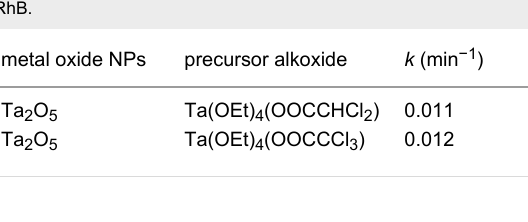
Table 3: Rate constants of photocatalytic degradation reactions of